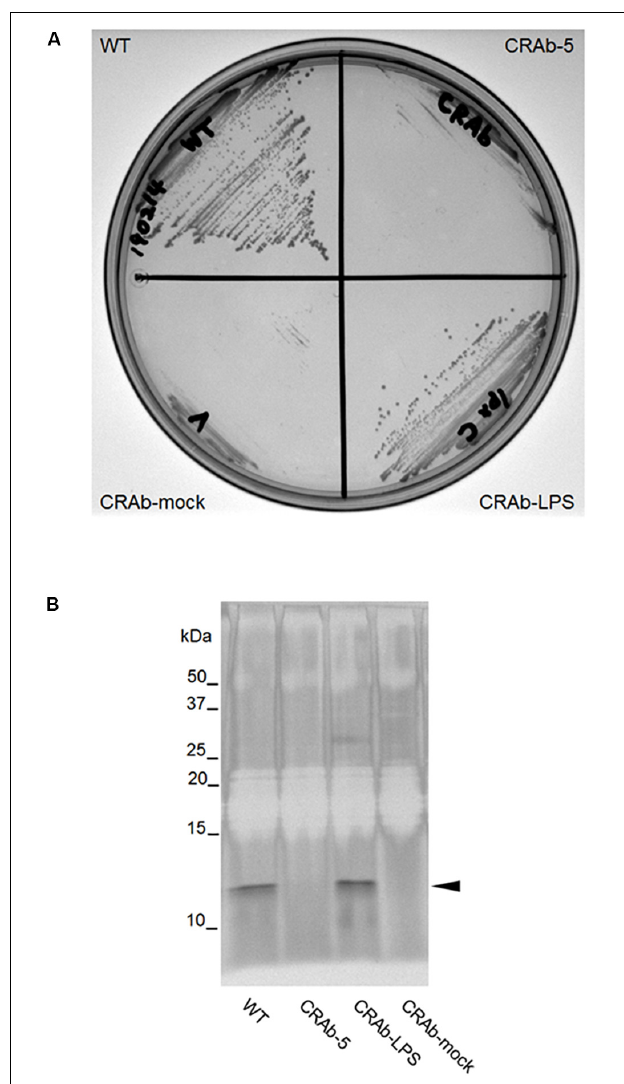
FIGURE 2 | Confirmation of lipopolysaccharide (LPS) complementation strain of colistin-resistant Acinetobacter baumannii (CRAb). (A) LPS complementation strain colony formation. ATCC 19606 (WT), CRAb-5, CRAb-LPS, and CRAb-mock were streaked on LB agar plates, cultured at 37 ◦ C for 18 h to confirm colony formation. LPS was purified from colonies. LPS preparations were separated by electrophoresis and visualized by silver stain (B) . Arrow: lipid